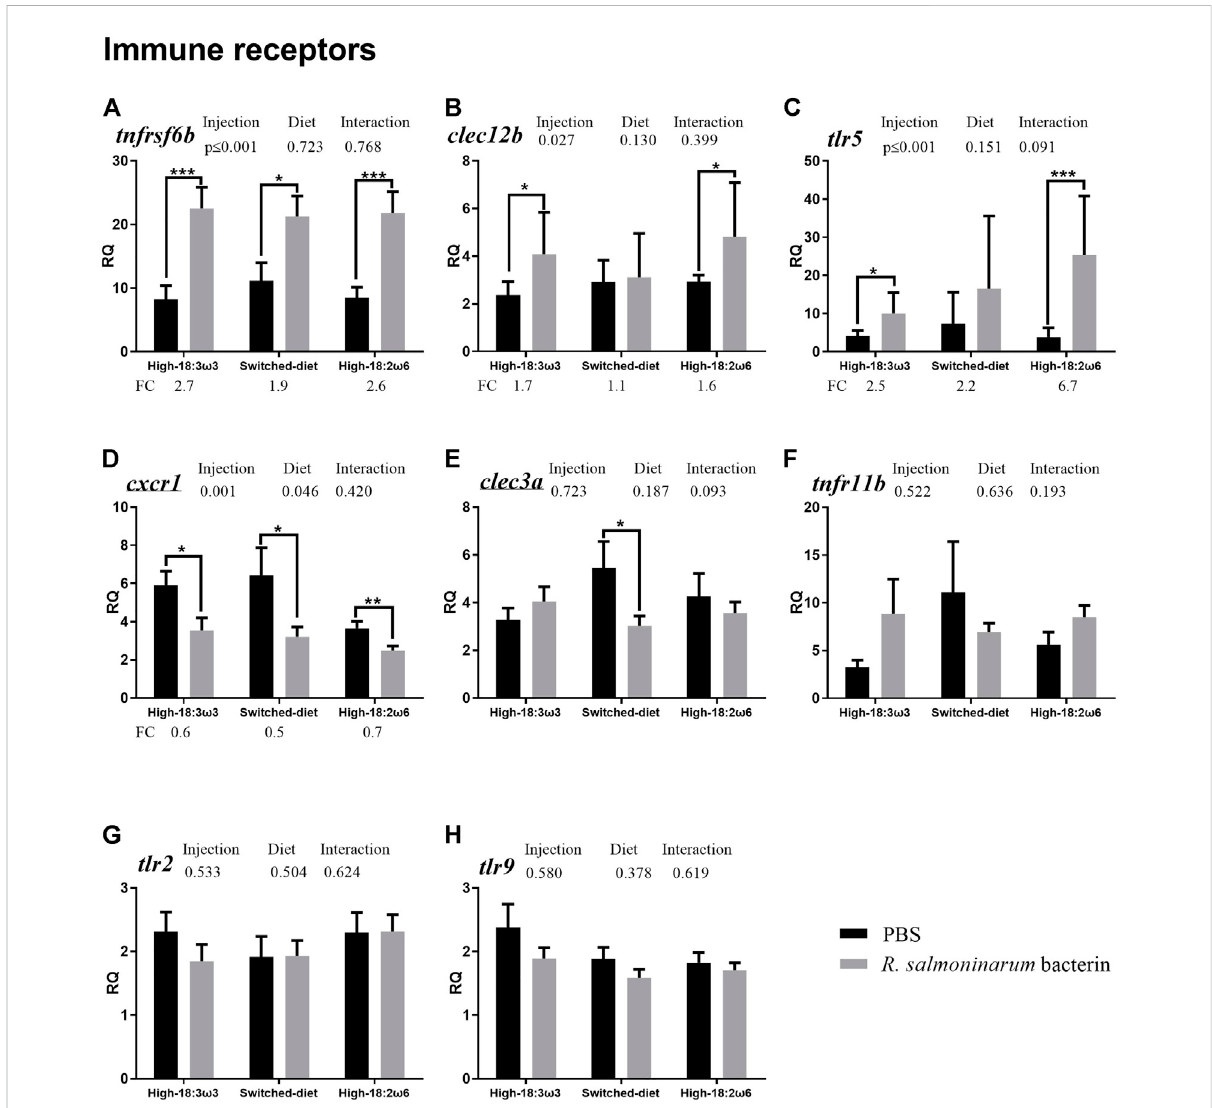
FIGURE 3 qPCR for transcripts representing the immune receptors ( (A – H) ; individual RQs used in the analysis n = 9). Two-way ANOVA results are shown in the table above each panel, and t -test results (i.e., signi fi cant differences betweenPBS and bacterin-stimulated fi sh within a diet group) are shown withasterisks ( “ * ” for p ≤ 0.05, “ ** ” for p ≤ 0.01,and “ *** ” for p ≤ 0.001). Data arepresentedas mean±SE.Overallfold-changevalues(FC; meanRQin bacterin-injected group/mean RQ in PBS-injected group) are shown below the transcripts with signi fi cant differences between groups. The signi fi cance threshold was adjusted to p ≤ 0.05. (A) tumor necrosis factor receptor superfamily member 6b ; (B) c-type lectin domain family 12- member b ; (C) toll-like receptor 5 ; (D) c-x-c chemokine receptor type 1-like ; (E) c-type lectin domain family 3-member a ; (F) tumor necrosis factor receptor superfamily member 11b ; (G) toll-like receptor 2 ; (H) toll-like receptor 9